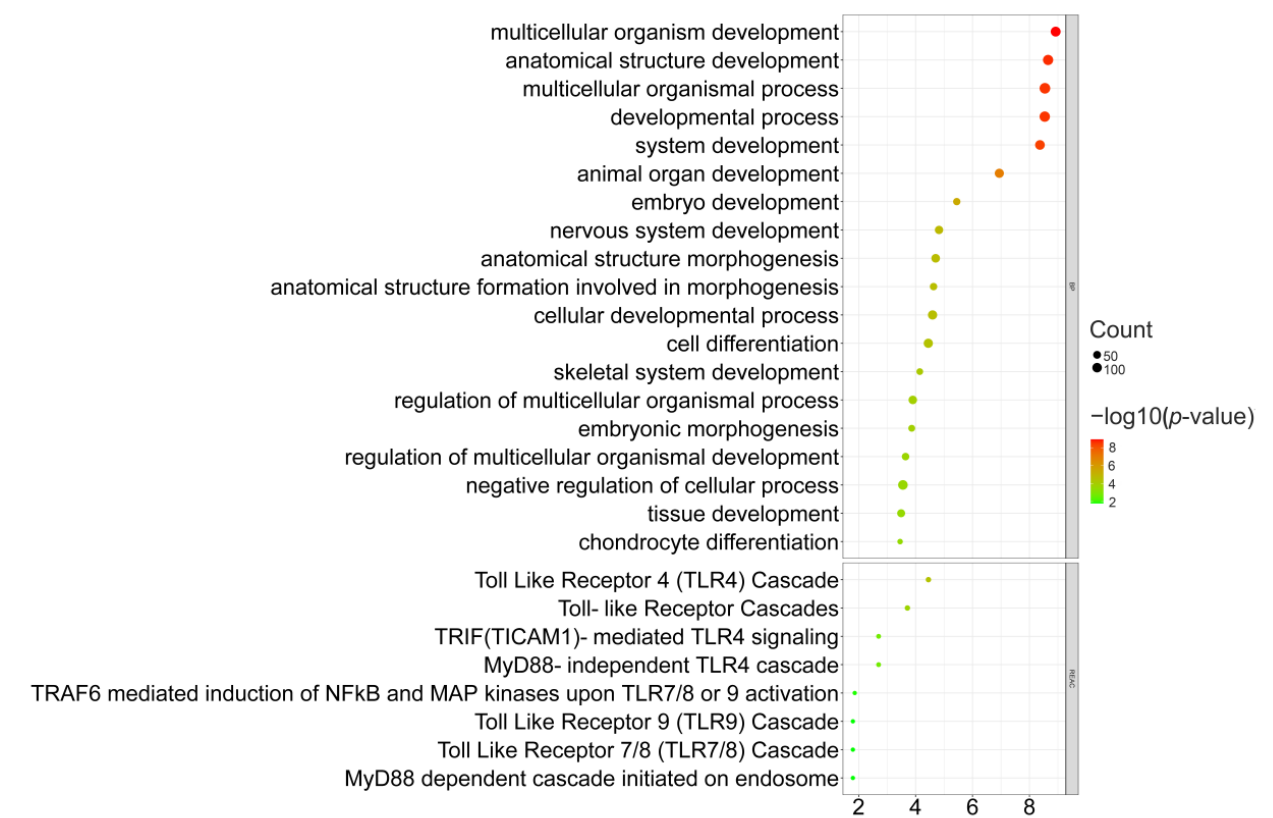
Figure 2. GO and KEGG pathway enrichment results of selected genes detected by at least two methods.